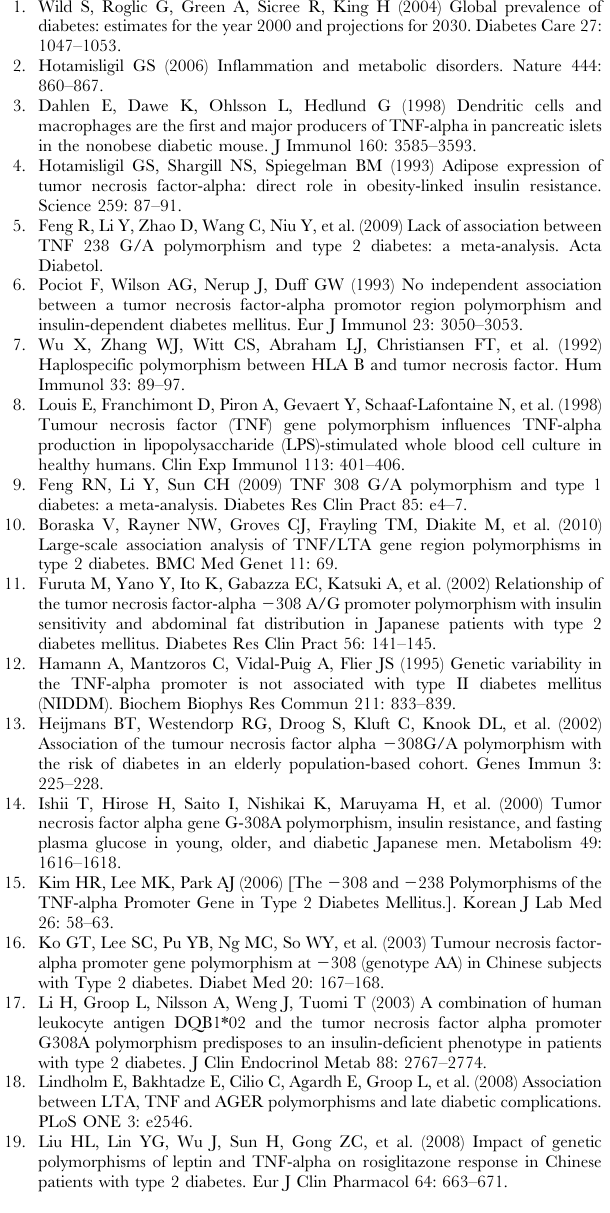
Figure S1 The flow chart of the included